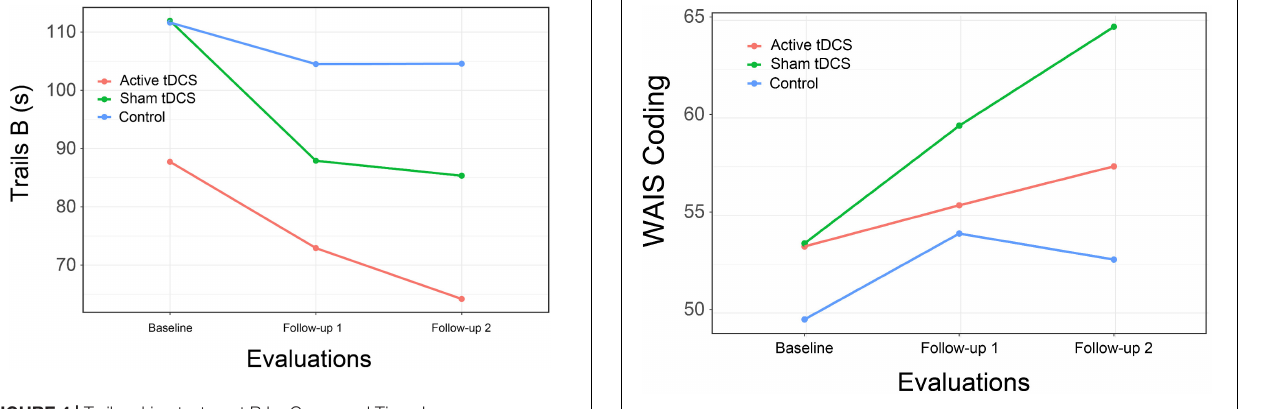
FIGURE 5 | WAIS-IV Coding subtest scores by Group and